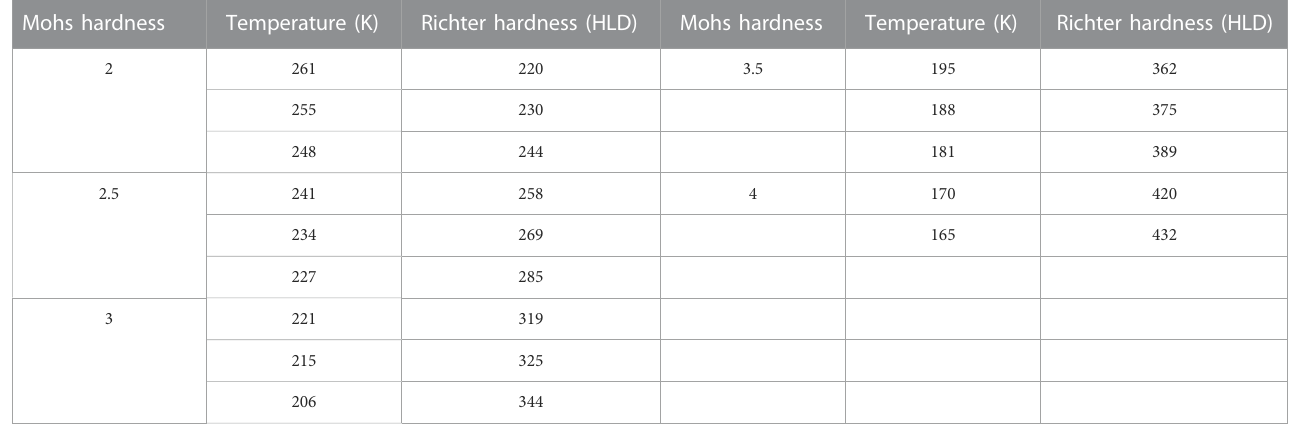
TABLE 3 Richter hardness of ice at different